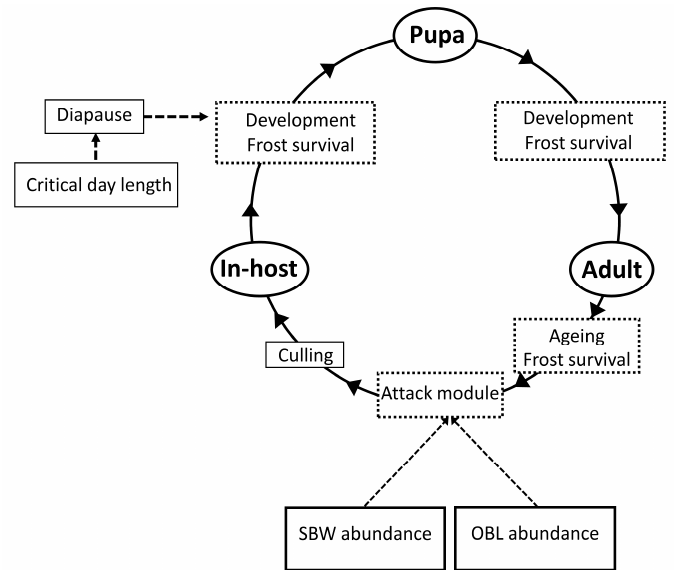
Figure 1. Flow chart of the model linking the parasitoid Actia interrupta to larvae of its two hosts, SBW and OBL. Models of SBW and OBL abundance are described in [19] and [23].